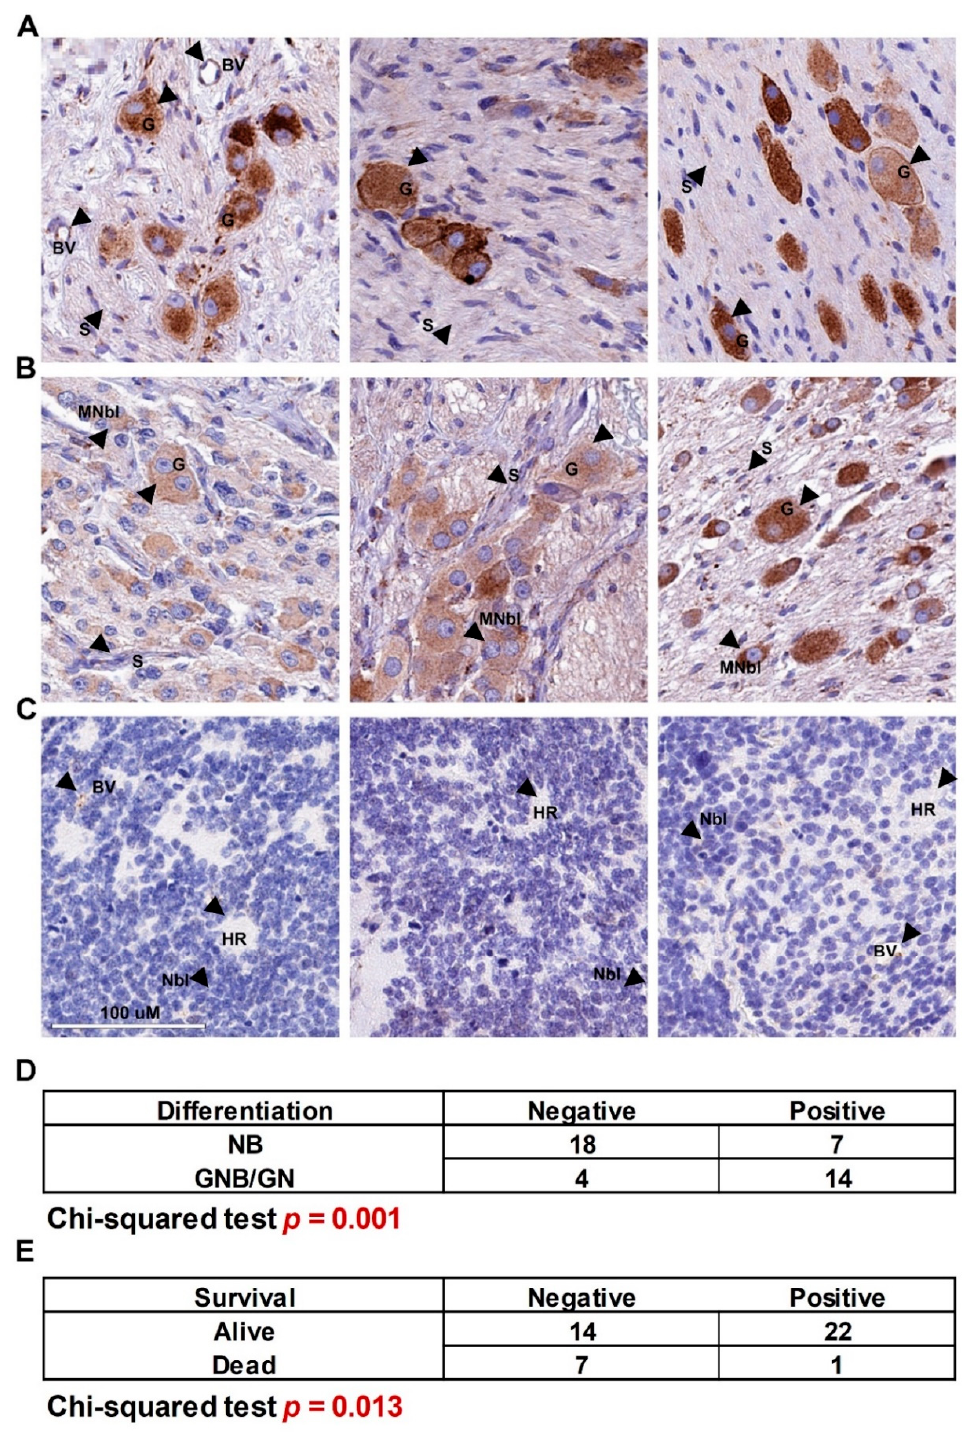
Figure 4. BMP4 immunohistochemistry in neuroblastic tumors. Expression of BMP4 protein in ( A ) mature ganglioneuroma, ( B ) ganglioneuroblastoma and maturing ganglioneuroma, ( C ) poorly differentiated neuroblastoma, where the third tumor is MYCN -amplified. BMP4 expression was positively and significantly correlated to ( D ) the degree of differentiation and ( E ) survival (Chi-squared test). Neuroblasts (Nbl), maturing neuroblasts (MNbl), ganglion cells (G), Schwannian stroma (S), Homer Wright rosettes (HR) and positively staining blood vessels (BV) are indicated with arrows.